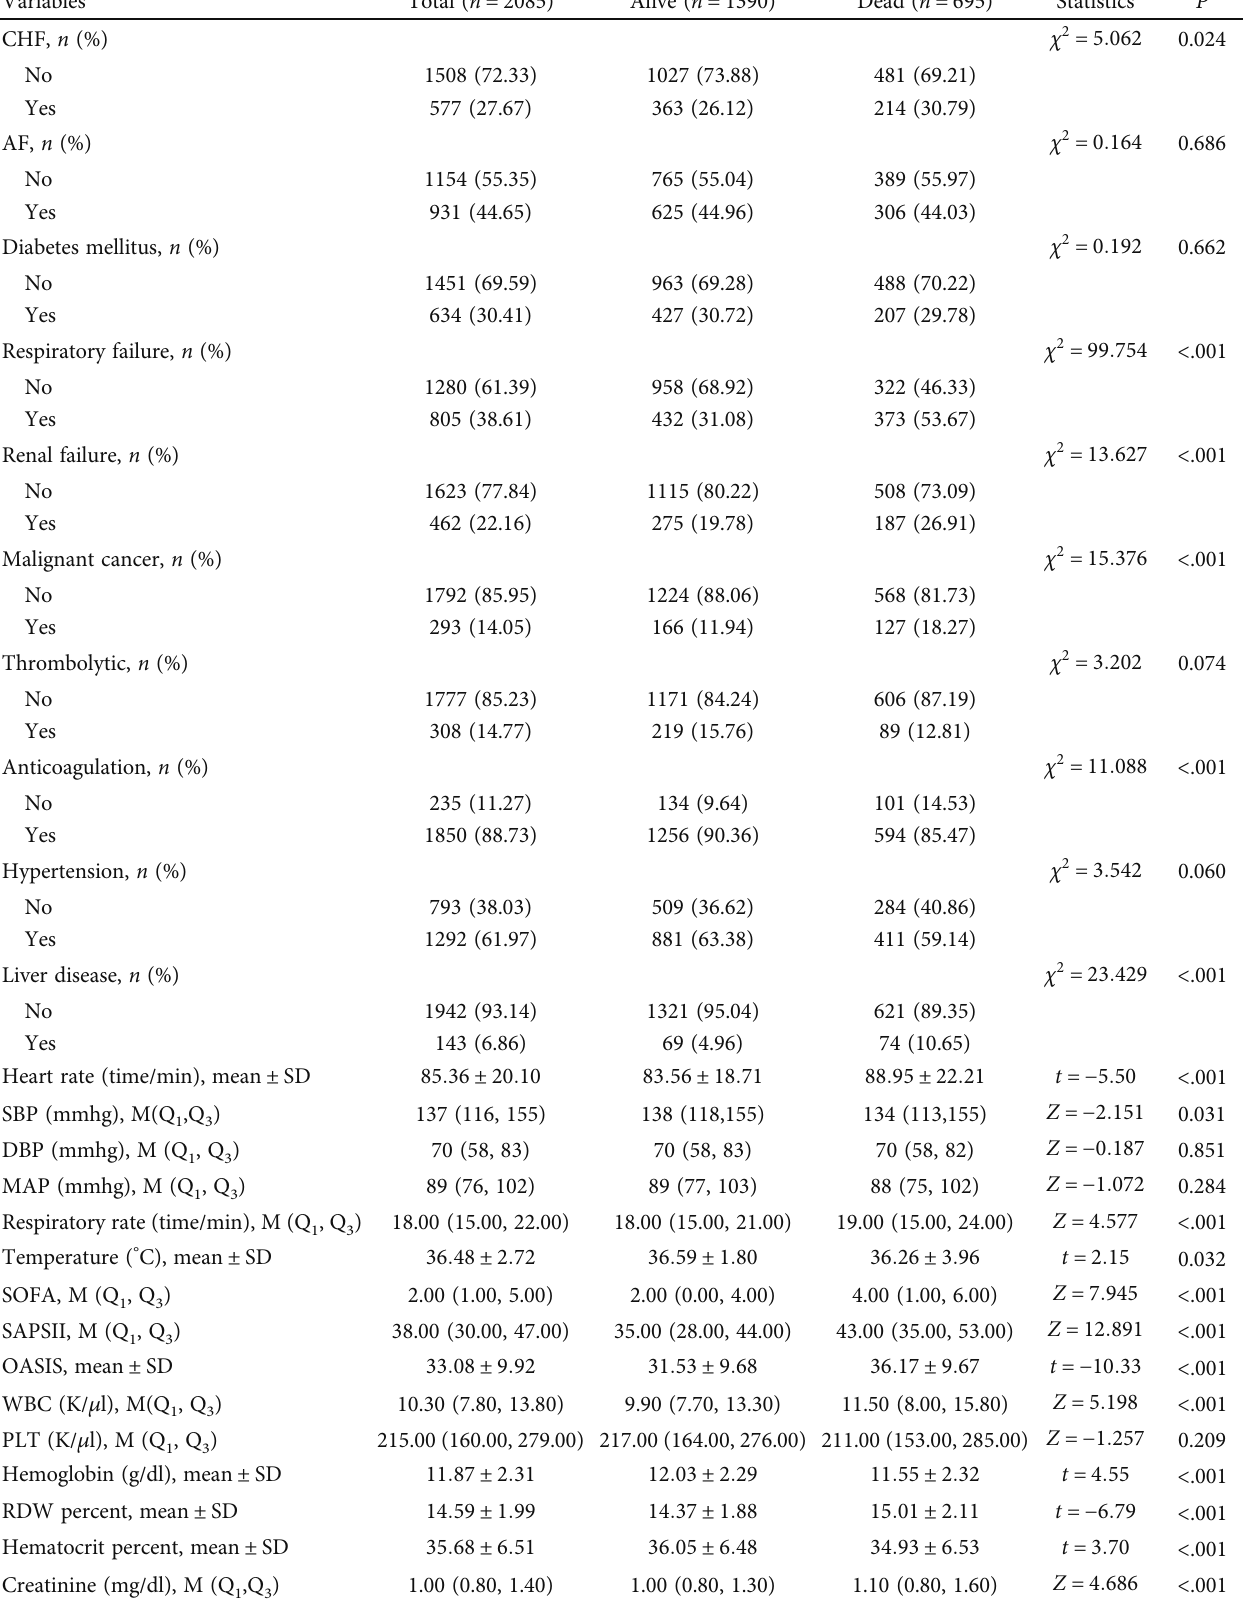
Table 1: Comparisons of the baseline characteristics between the alive group and the dead